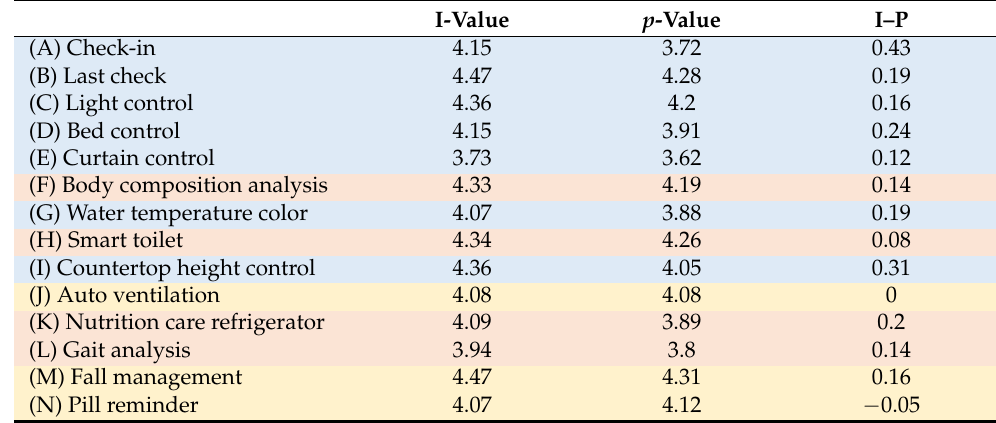
Table 7. Statistics (older